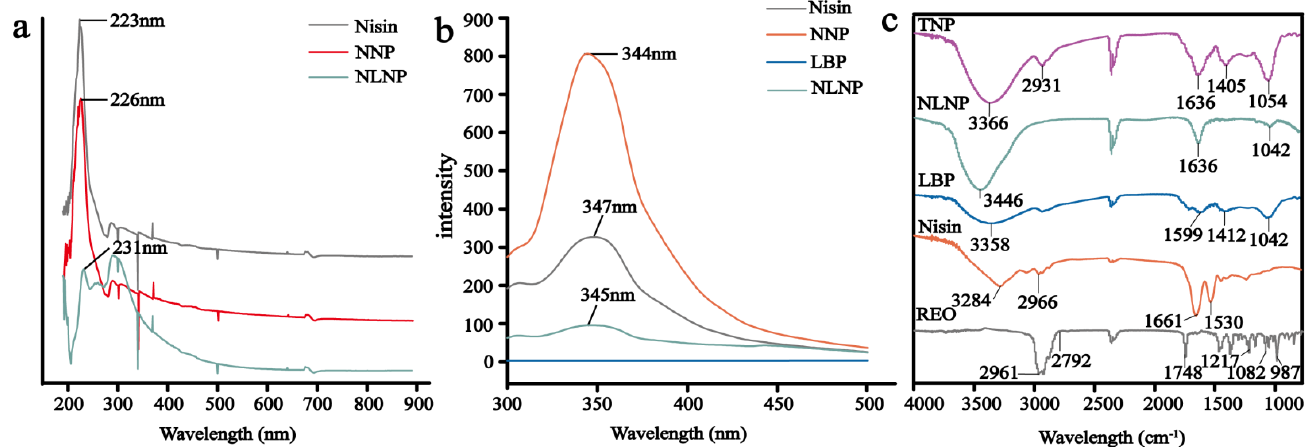
Figure 2. The spectral analysis of nanoparticles including UV-vis absorption spectrum( a ) and Fluo- rescence spectroscopy( b ) of Nisin, NNP and NLNP; FTIR spectrum( c ) of REO, Nisin, LBP, NLNP and TNP.